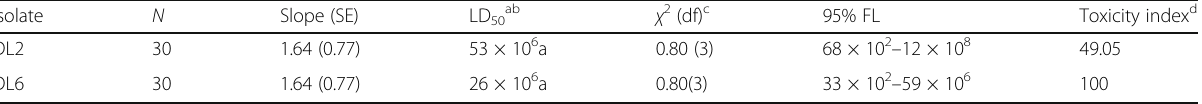
Table 4 Toxicity values of DL2 and DL6 isolates to 4th instar nymphs of Schistocerca gregaria using per os bioassay technique Isolate